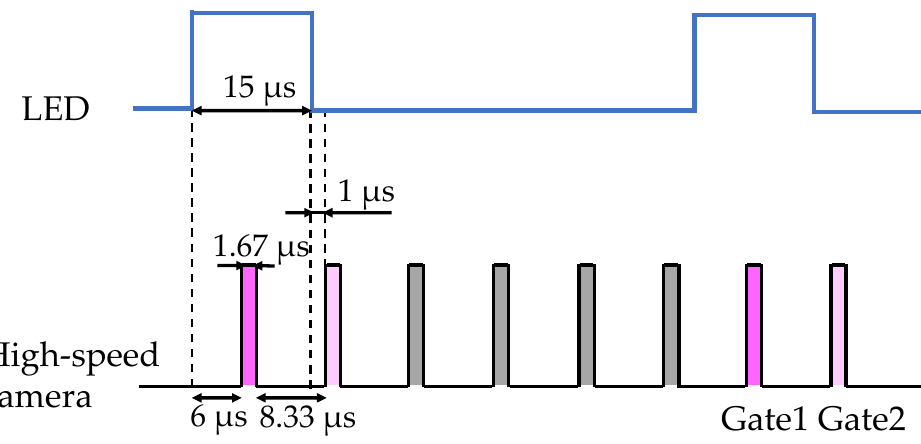
Figure 3. Time sequence of LED and high-speed camera.